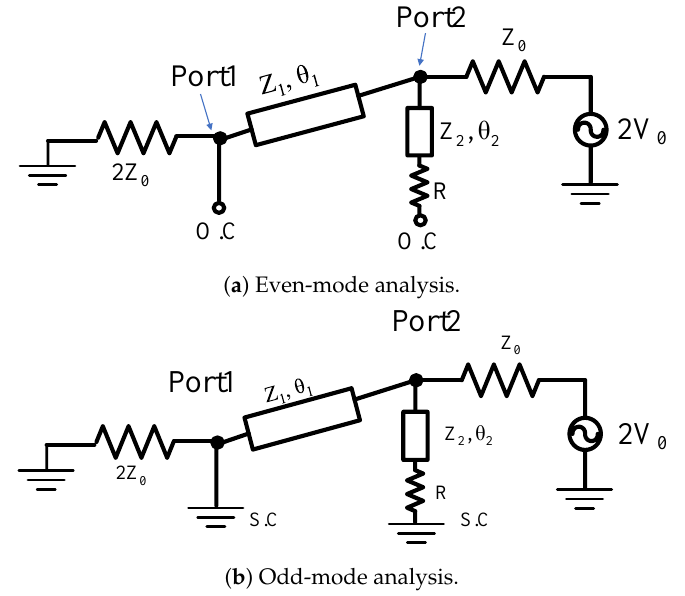
Figure 3. Even and odd mode Analysis of the proposed